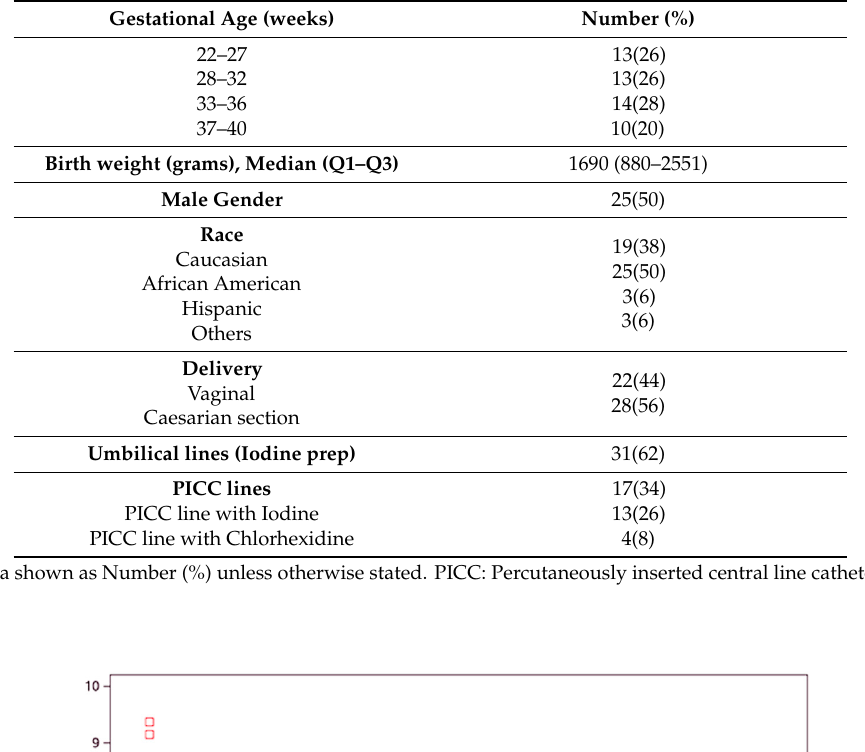
Table 1. Infants’ demographic characteristics.